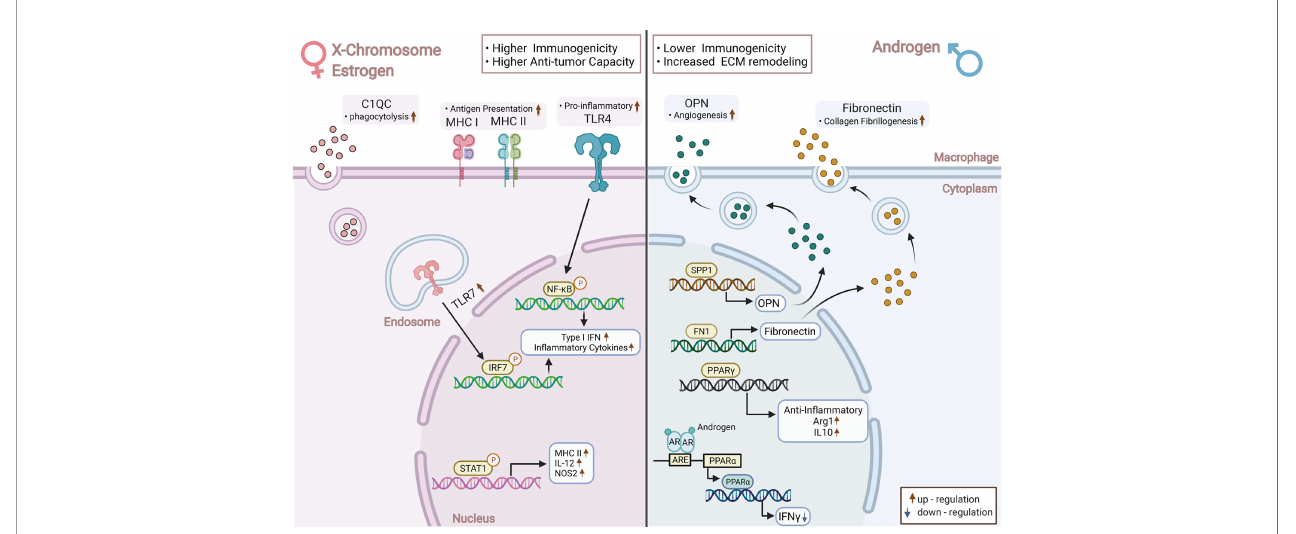
FIGURE 6 | Overview of the Key Transcriptome and Functional Changes in TAMs between Sexes. Female-derived TAMs presented higher immunogenicity, stronger anti-tumor ability with increased expression of TLR-mediated in fl ammatory factors, and enhanced antigen presentation capacity; Male-derived TAMs were more immunosuppressed, to which upregulated PPAR-associated pathways contributed considerably. A higher level of complement-related C1QC was found in female- derived TAMs, while male-derived TAMs elevated the expression of matrix remodeling-relevant genes — SPP1 and FN1. Chromosome and sex hormone differences may be the main reasons for the above heterogeneity; TAMs: Tumor-Associated Macrophages; TLR: Toll-like Receptors; PPAR: Peroxisome Proliferator-Activated Receptors Gamma. This picture was created with BioRender.com (Agreement number: